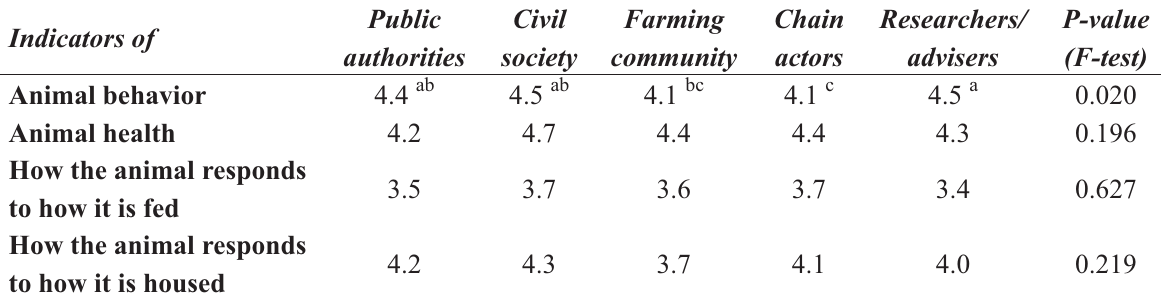
Table 6. Rating (1 to 5 scale 1 ) of the effectiveness of ‘Animal–based’ indicators according to each Expert category (means) (source: [71]).